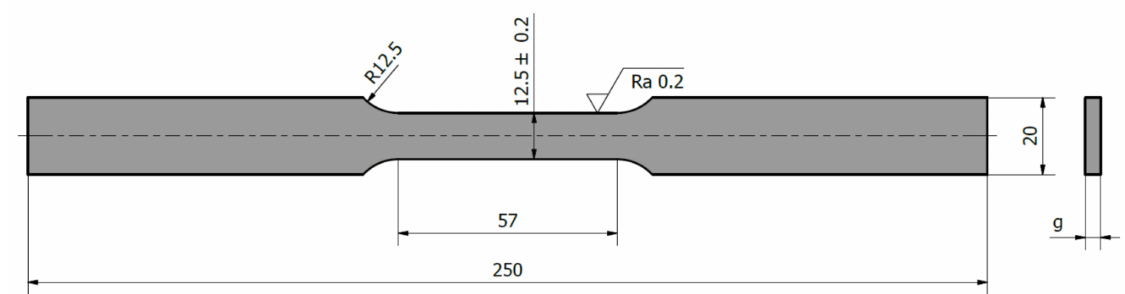
Figure 3. The geometry of test specimens ( g -specimen thickness depending on the sheet plate thickness).